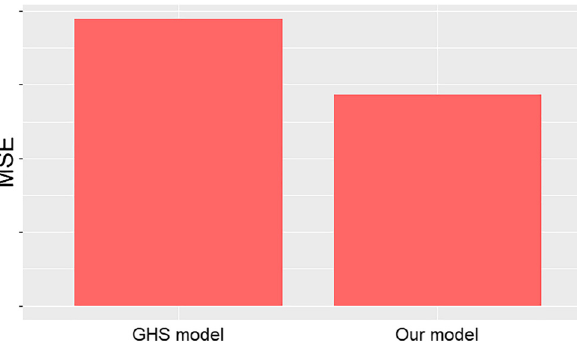
Table 1. Statistical results based on the model in Eqn